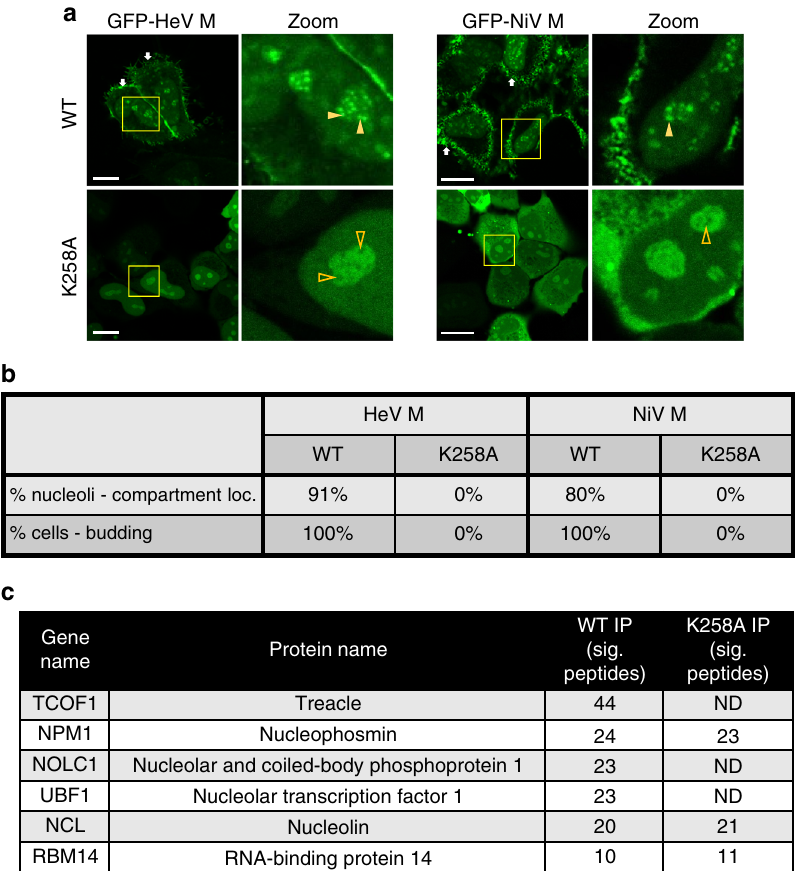
Fig. 2 Mutation of residue K258 to alanine inhibits localization to subnucleolar compartments, binding to a subset of nucleolar proteins, and budding function of M protein. a HeLa cells transfected to express the indicated proteins were analyzed by live-cell CLSM; white arrows indicate localization of M protein at the plasma membrane/membrane protrusions; fi lled and un fi lled yellow arrowheads indicate subnucleolar compartments with apparent accumulation and exclusion, respectively, of M protein. Scale bars correspond to 15 μ m. b Images such as those in a were used to determine the percentage of nucleoli with clear accumulation of M protein in subnucleolar compartments (% nucleoli — compartment loc.; ≥ 447 nucleoli analyzed for each of WT and K258A-mutated HeV M protein, from four separate assays; ≥ 99 nucleoli analyzed for each of WT and K258A-mutated NiV M protein, from two separate assays), and the percentage of cells with localization of M protein to concentrated patches at the plasma membrane and into membrane protrusions, consistent with budding (% cells — budding; ≥ 83 cells analyzed for each sample from at least two independent experiments). c A subset of nucleolar interactors of GFP-HeV M and GFP-HeV M-K258A identi fi ed by IP/MS; proteins are ranked by number of signi fi cant (sig.) peptides identi fi ed; ND